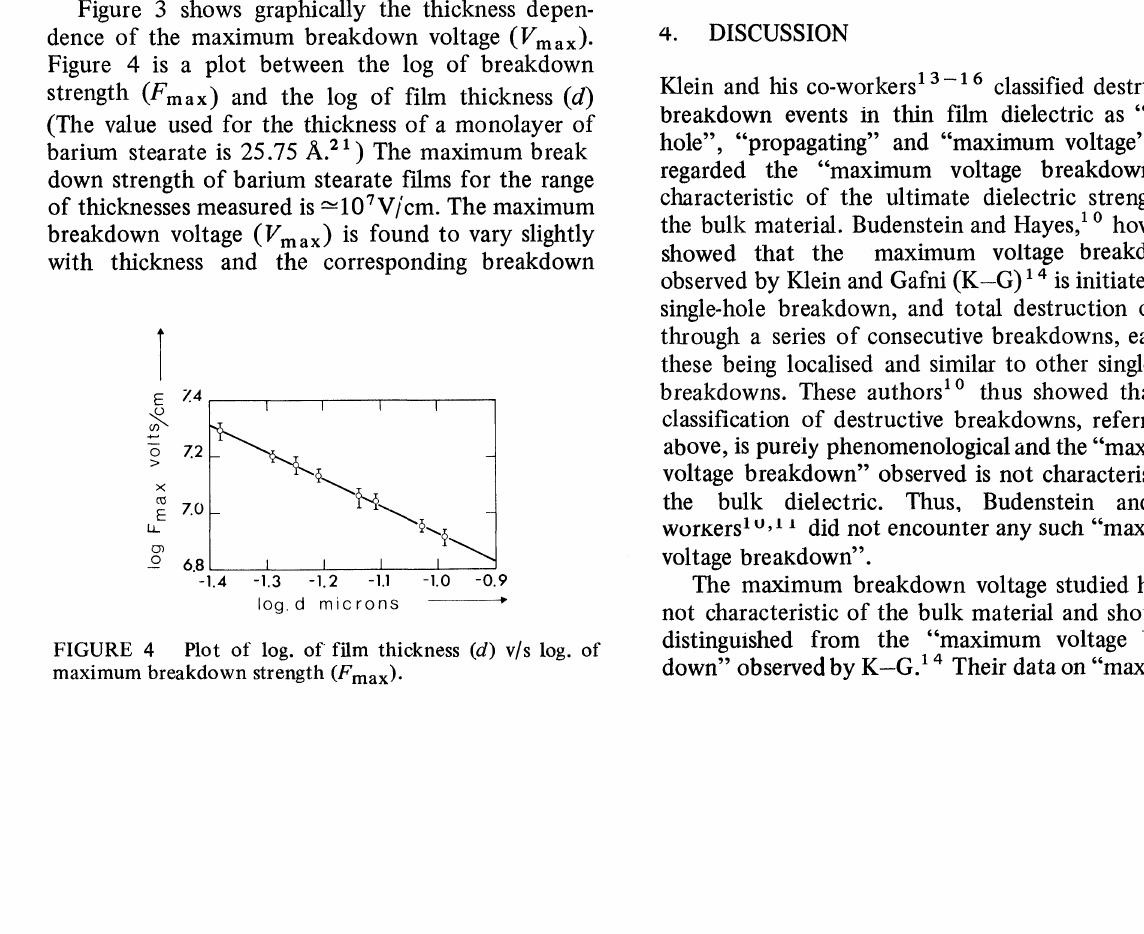
FIGURE 5 Transmission photomicrograph showing the destruction at maximum breakdown voltage (x40). strength (Fmax) is a power-dependent function of film thickness (d) varying as d -a where c 0.96. Figure 5 is a representauve transmission photo- micrograph (x40) showing the destruction of the film capacitor (area about (0.4 cma), of thickness about 400 (16 layers), over large areas at an applied Plot of number of layers (N) v/s maximum breakdown voltage (l/max). voltage of 84 volts and with a series resistor (---5 K).